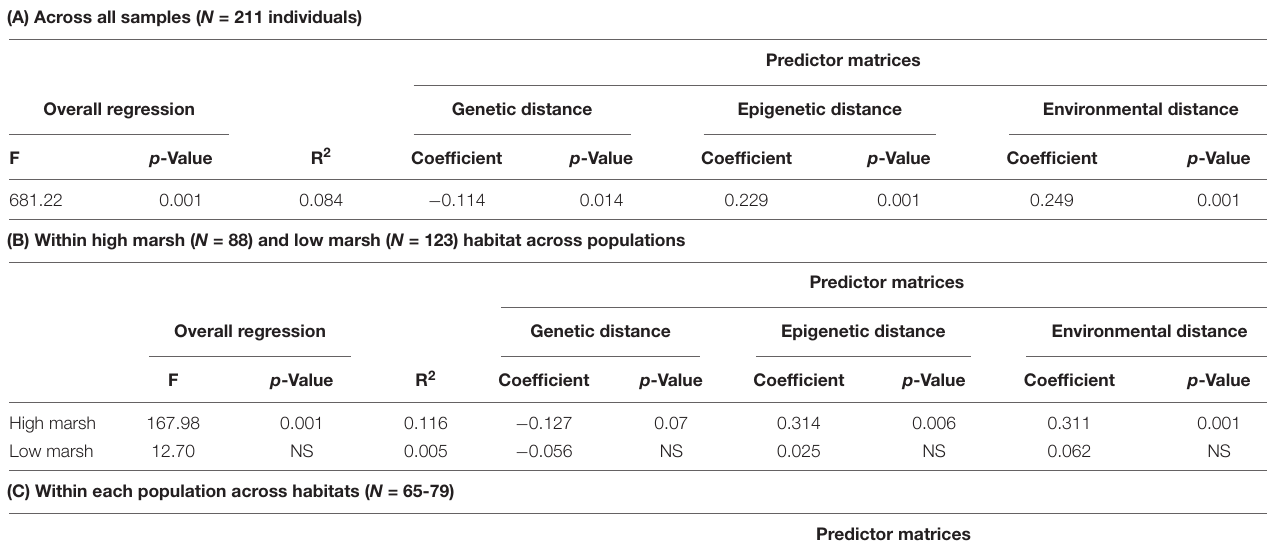
TABLE 6 | Results of multiple matrix regression with randomization (MMRR) analysis relating the combined phenotypic distance matrix across all S. alterniflora samples with the matrices of genetic (SNP), epigenetic (SMPs), and environmental distances for (A) across all samples, (B) within each habitat type across populations, (C) within each population across habitats and (D) for each subpopulation. NS indicates p value > 0.10.